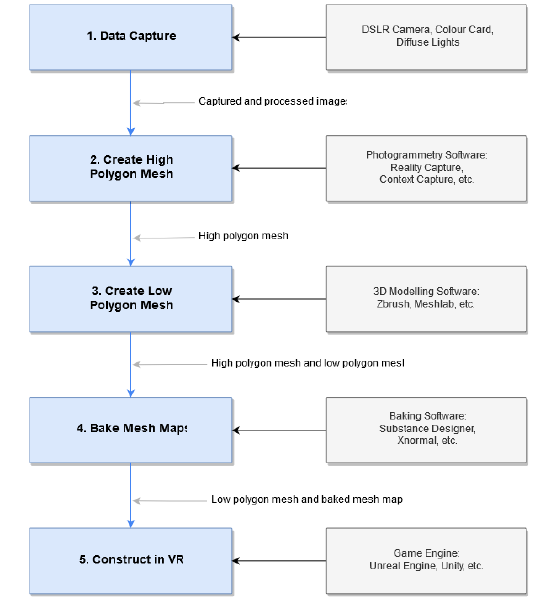
Figure 1. Photogrammetry to VR workflow